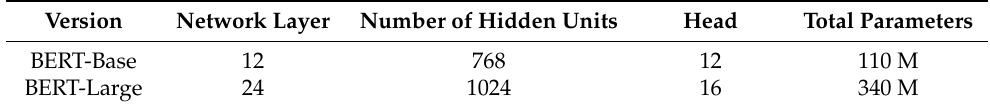
Table 2. Hyperparameters of the two BERT models.